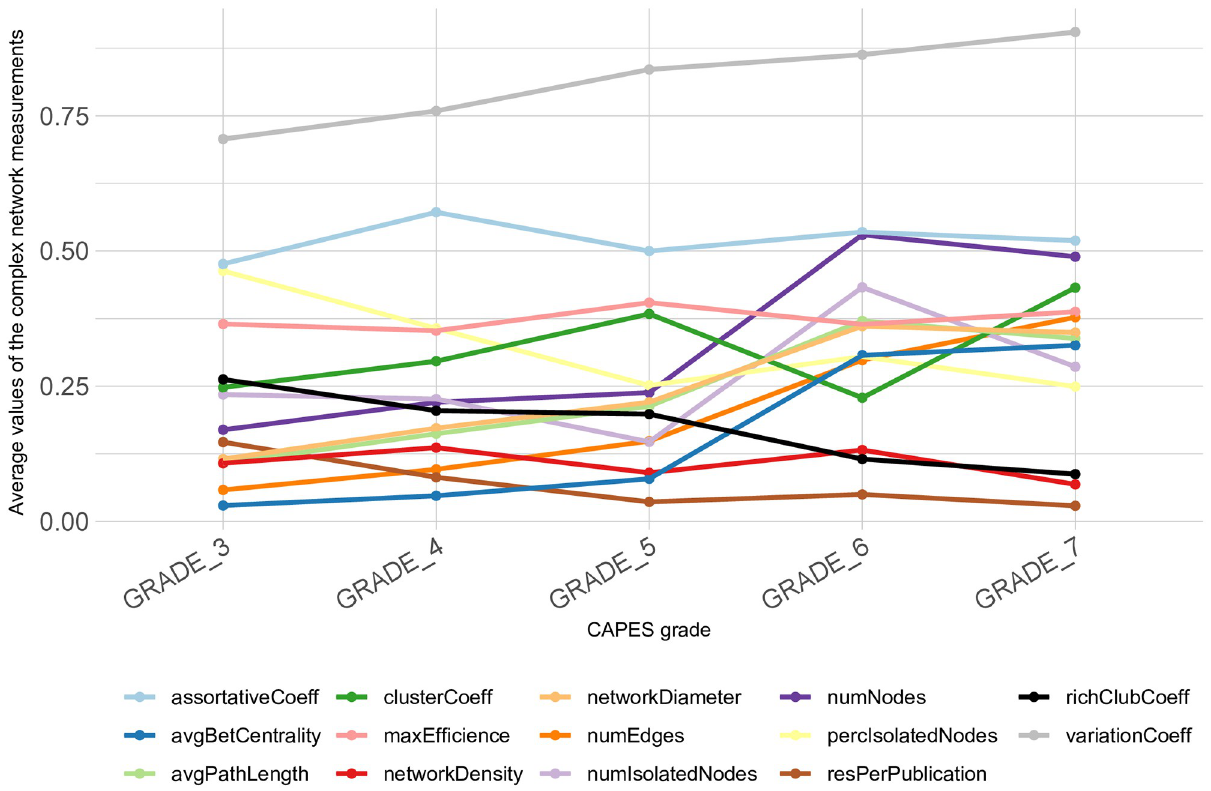
Fig 5. Average of the most important complex network measurements regarding the CAPES